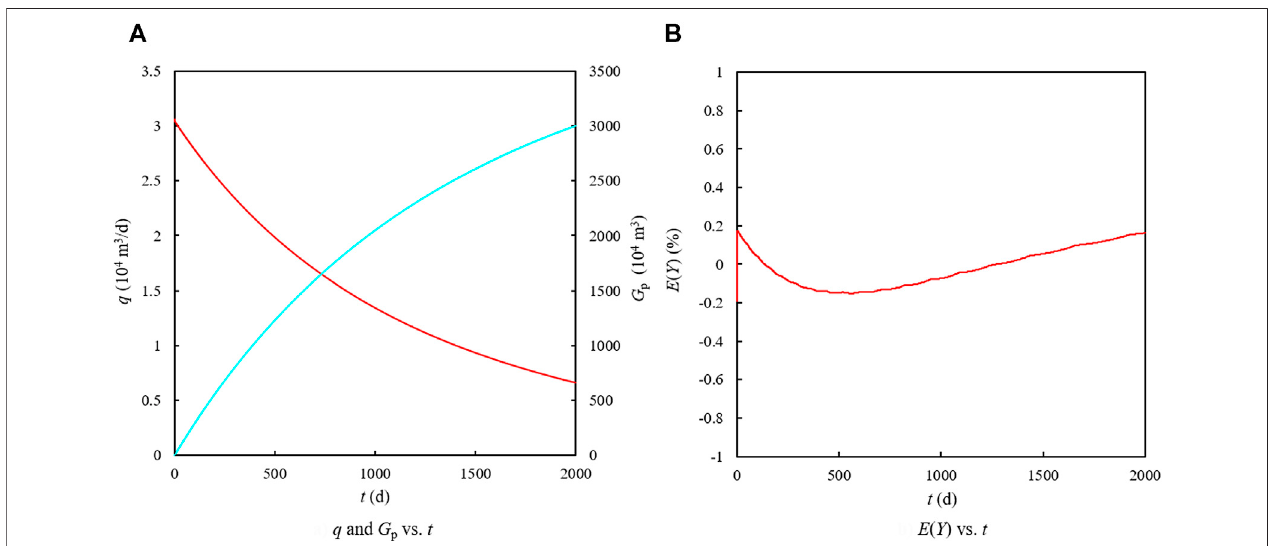
FIGURE 6 | q , G p and E ( Y ) vs. t for the constant-BHP case.